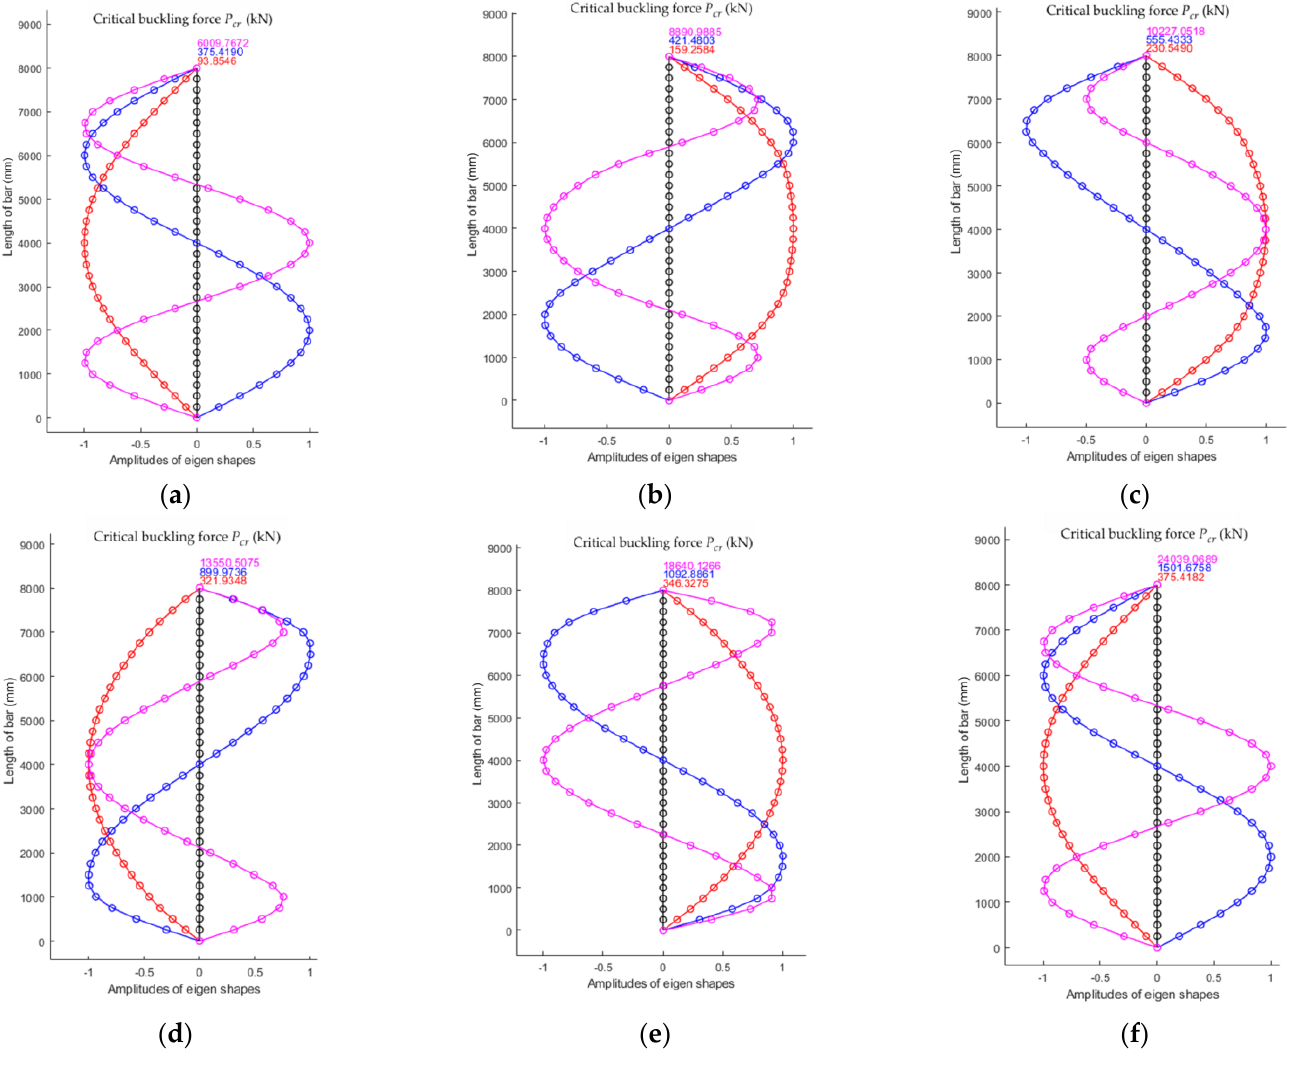
Figure 15. The first three shapes of stability loss and corresponding critical forces 𝑃 𝑐𝑟 obtained by the FEM for the six cases of bars analyzed: ( a ) CONST_1I; ( b ) STEPWISE405; ( c ) STEPWISE410; ( d ) STEPWISE420; ( e ) STEPWISE430; and ( f ) CONST_4I (details about each case are given in Table 2).